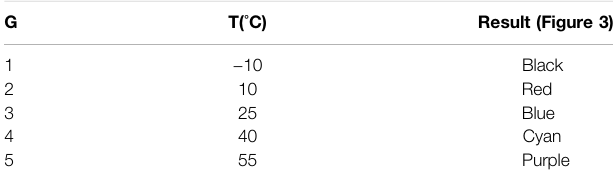
TABLE 2 | PV arrays at different temperatures with the same voltage (light intensity).